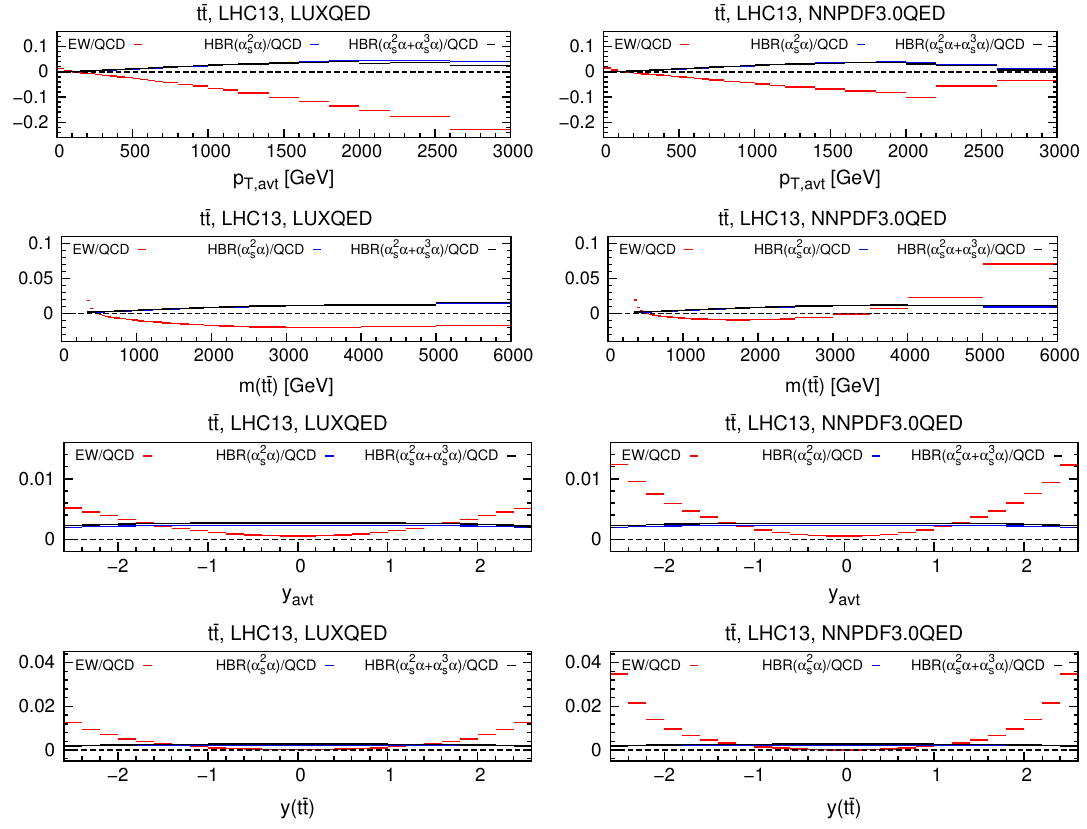
Figure 7 . Impact of heavy boson radiation (HBR) on the p T; avt , m ( t (cid:22) t ), y avt and y ( t (cid:22) t ) di(cid:11)erential distributions at 13 TeV. The format of the plots is described in the